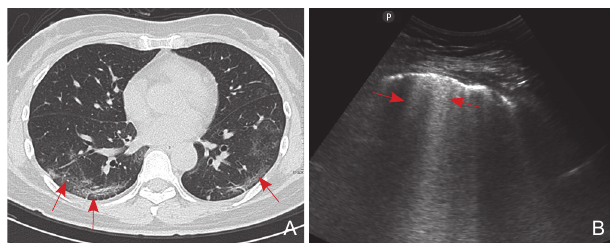
A B Figure 1 A 51-year-old female patient with an exposure history of traveling to Wuhan, presented with fever and cough for 9 days. (A) Chest CT shows multiple patchy ground grass opacities (GGO) (arrows) in the bilateral peripheral lung. (B) Lung US in the corresponding location shows confluent B lines (waterfall sign) (arrows).